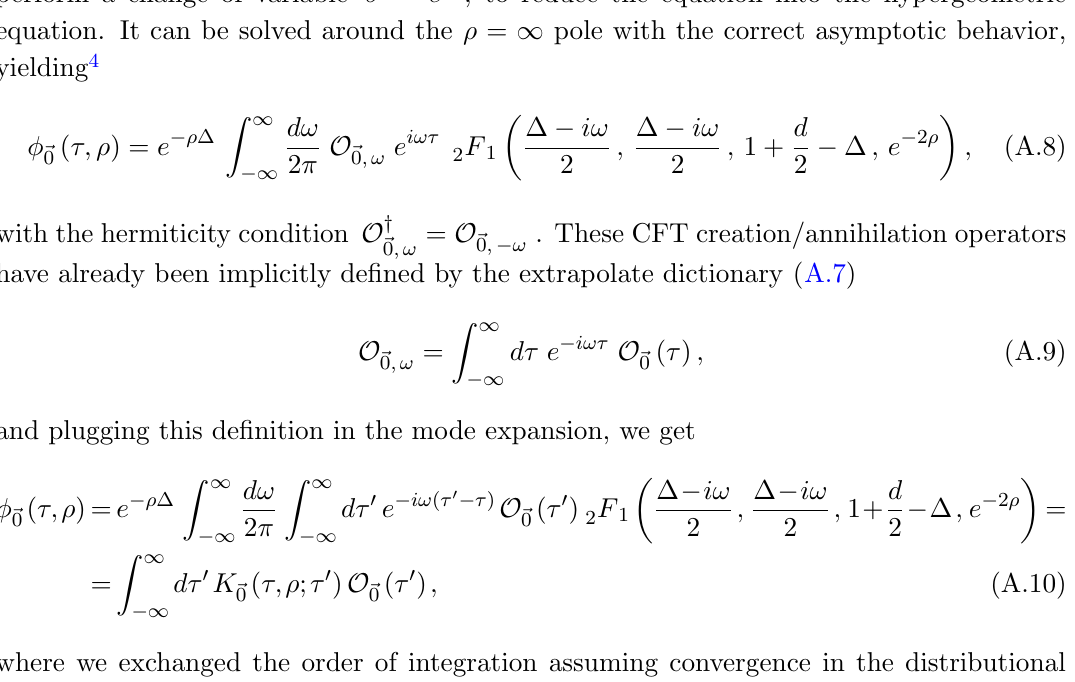
( (cid:26) ) = e i!(cid:26) (cid:30) ( (cid:26) ), and then ~ 0 ;! ~ 0 ;!